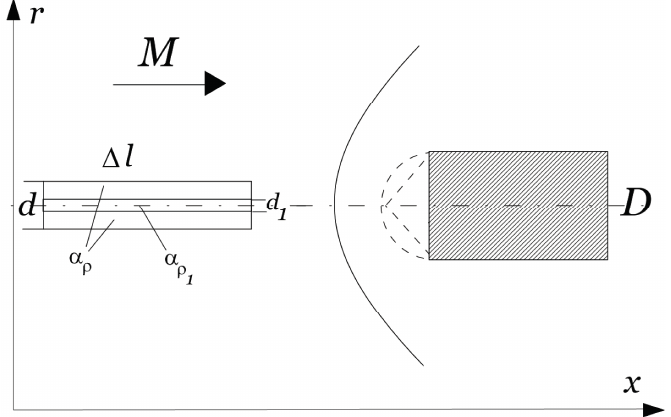
Figure 1. Schematic of the flow and accepted